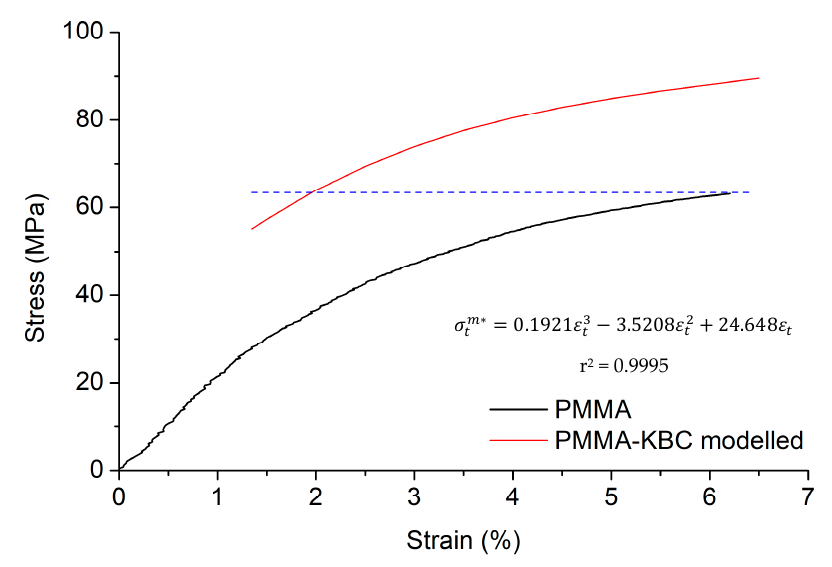
Figure 6. PMMA experimental curve and PMMA-KBC modeled curve obtained from the simulation of the experimental results in the rule of mixtures (ROM). The blue dash line indicates the maximum strength of PMMA polymer matrix.